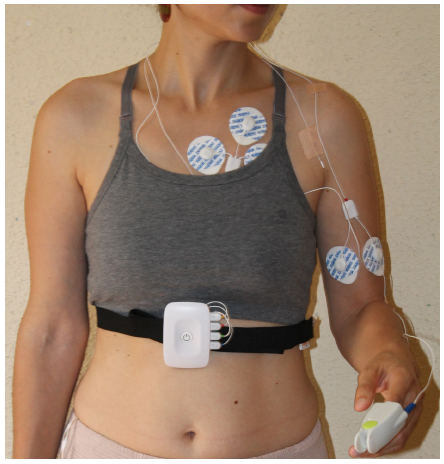
Figure 1. Patient wearing the monitoring